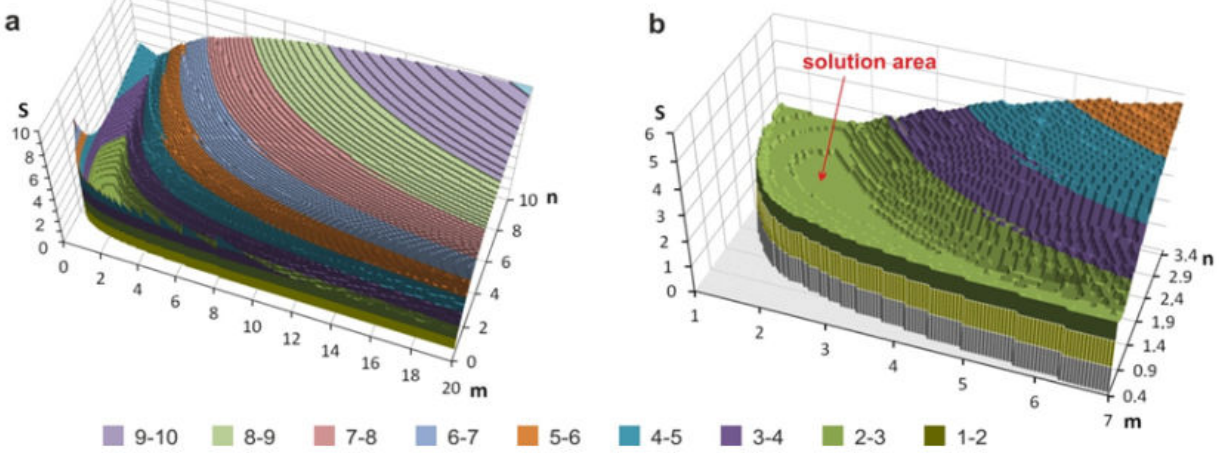
Figure 11. Distribution of objective function S s in function of shape parameters m and n of the Strupczewski formula: ( a ) within the adopted range of parameters m and n , ( b ) with magnification of the area meeting the objective